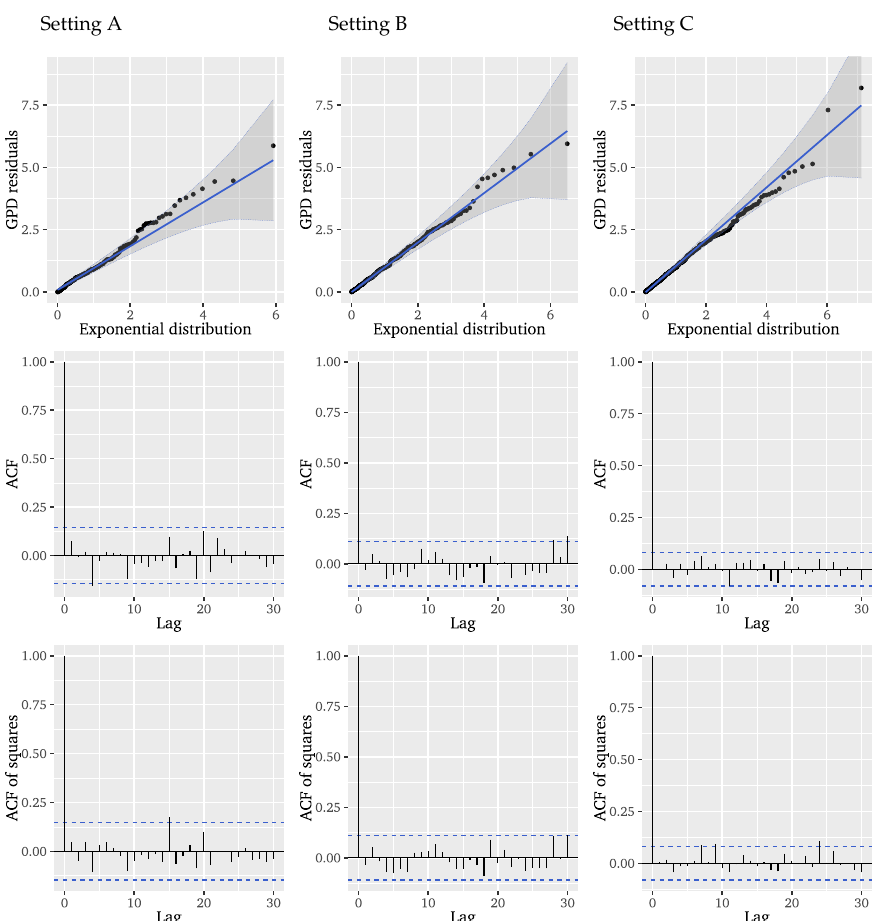
Figure 18. Unit exponential QQ plot and auto-correlation functions for the GPD residuals of the ARFIMA-POT for the three simulated settings A, B and